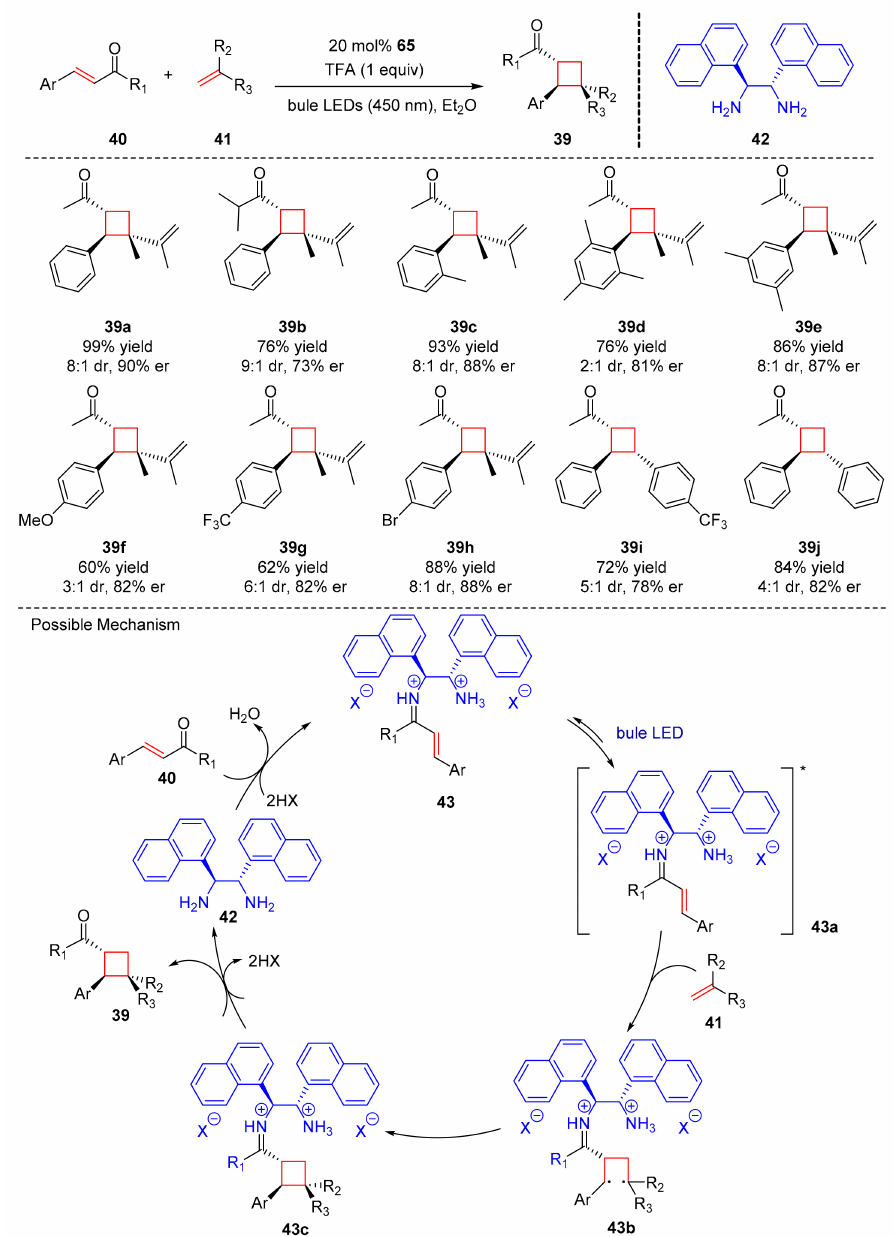
In 2020, Takagi et al. reported an enantioselective intramolecular [2+2] photocy- cloaddition of 4-bishomoally-2-quinolones ( 62 ). When phosphoric acid ( 63 ) was used as a photocatalyst, cycloaddition products ( 64 ) were obtained with good yields and enantiose- lectivity (up to 88% yield, up to 92% ee) under the irradiation of visible light ( λ > 290 nm) (Scheme 15) [25]. Methyl groups at the 6- and 8-positions of the substrates were well tolerated, while oxygen atoms could reduce the enantioselectivity of the products. The reaction occurred from a complex ( 65 ) formed by substrate ( 62b ) and phosphoric acid ( 63 ) through dual hydrogen bonding, then the olefin moiety on the complex reacted with the enone moiety to form cycloadduct ( 64b ) via